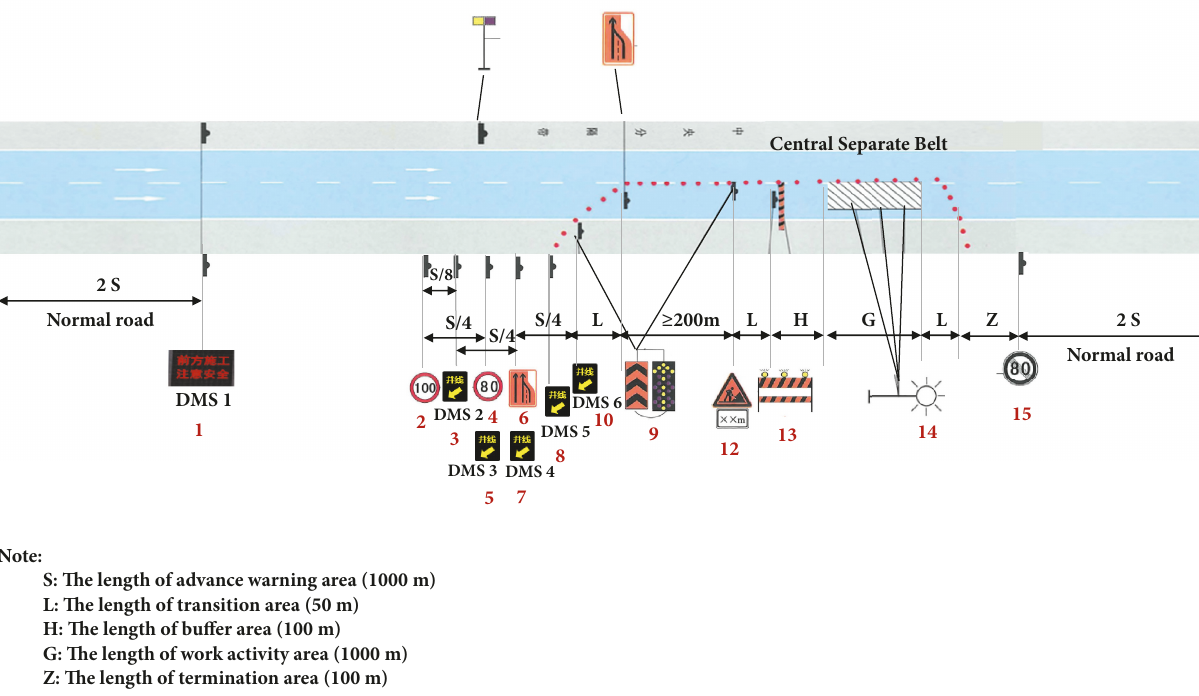
to detect a sign (D 𝑠𝑖𝑔𝑛 𝑑𝑒𝑡𝑒𝑐𝑡𝑖𝑜𝑛 ), the distance for drivers to read a sign (D 𝑠𝑖𝑔𝑛 𝑟𝑒𝑎𝑑𝑖𝑛𝑔 ), the correction factor (f), the slope